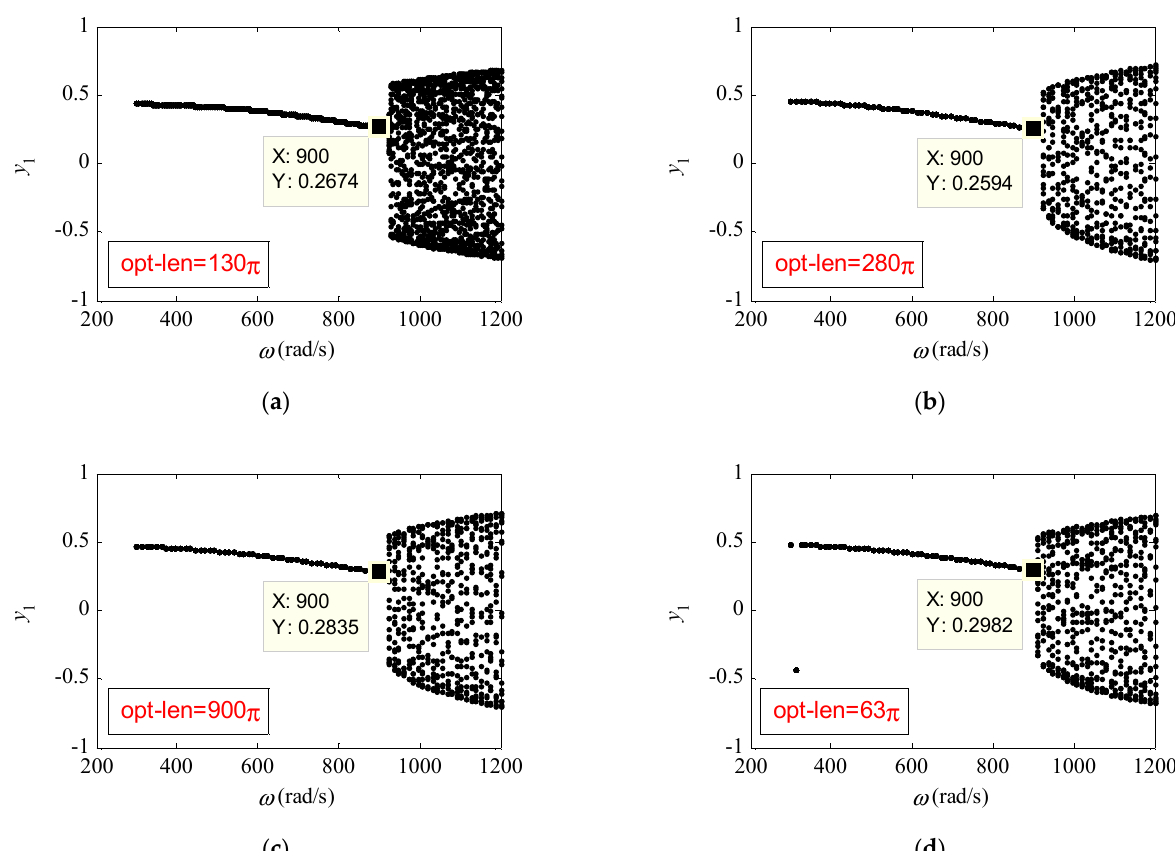
Figure 8. Bifurcation diagrams of POMs of 2-DOFs obtained by the optimal sampling lengths at 4 different sampled rotational speeds: ( a ) 350 rad/s, ( b ) 500 rad/s, ( c ) 700 rad/s, ( d ) 1000 rad/s.